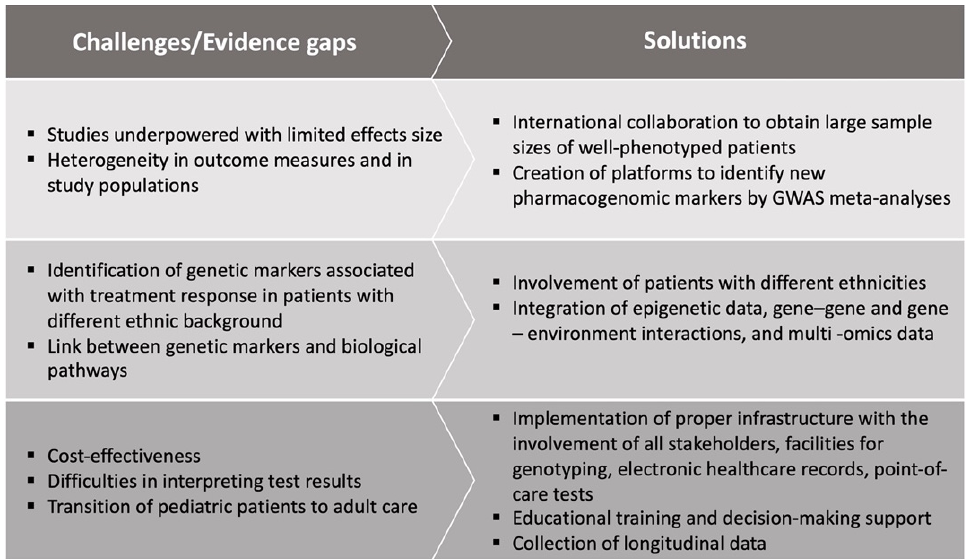
Figure 1. Challenges and evidence gaps associated with pharmacogenomics in childhood asthma research and practice. research and